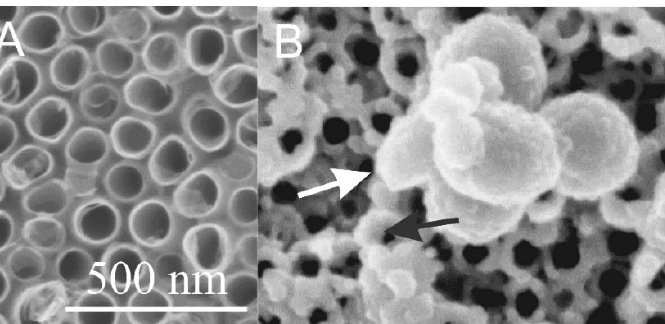
Figure 4. Scanning electron microscope (SEM) images of TiO 2 nanotubular surface ( A ) and the TiO 2 nanotubular surface that was exposed to the isolate of extracellular vesicles (white arrow) from blood ( B ). Material deposited also on the top surface of the TiO 2 nanotube walls is denoted by a black arrow. Adapted with permission from [60,61] .